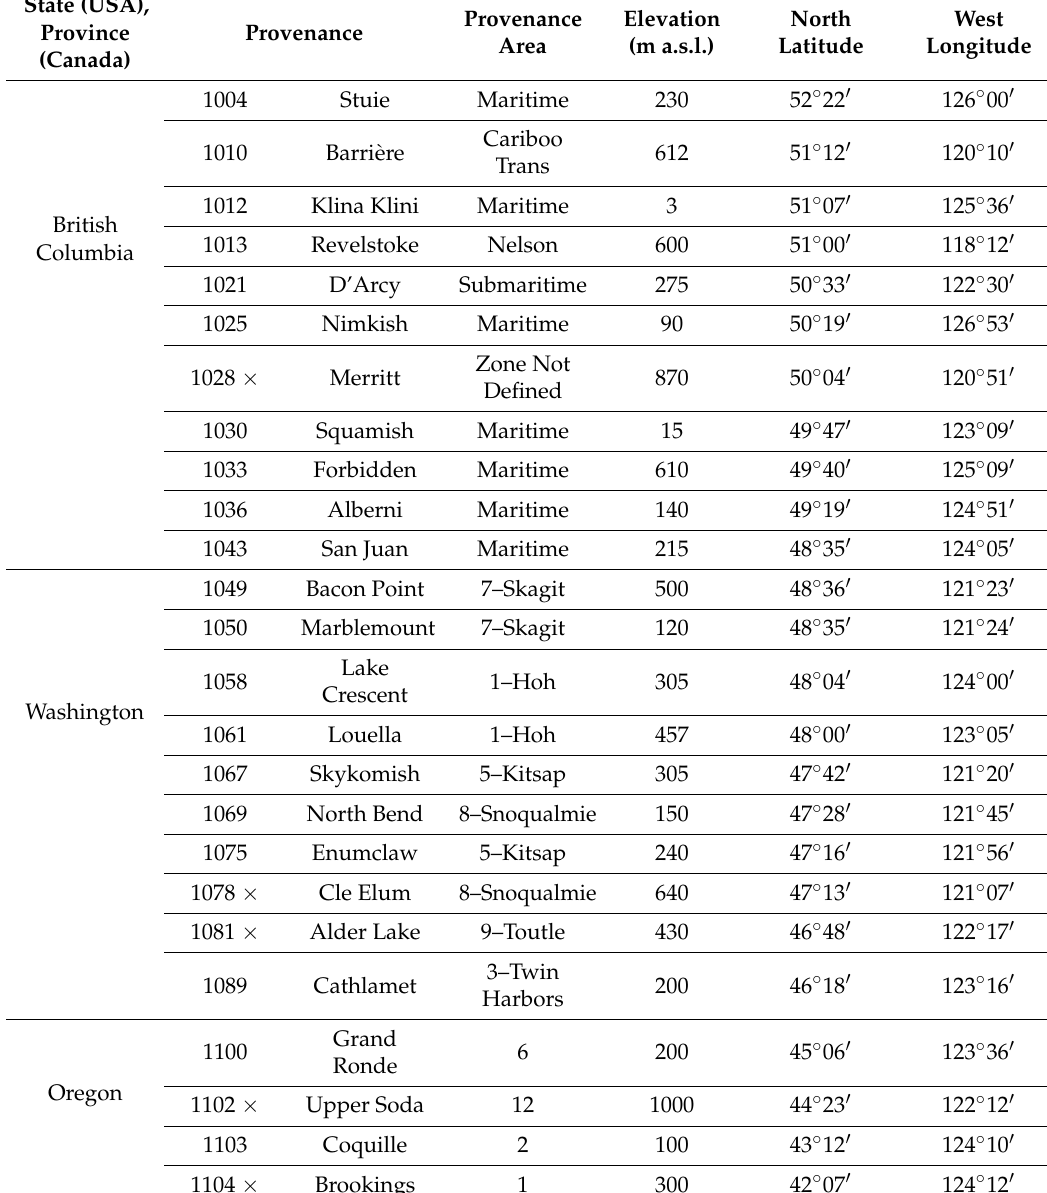
Table 1. Characteristics of evaluated provenances at the H ˚ u rky